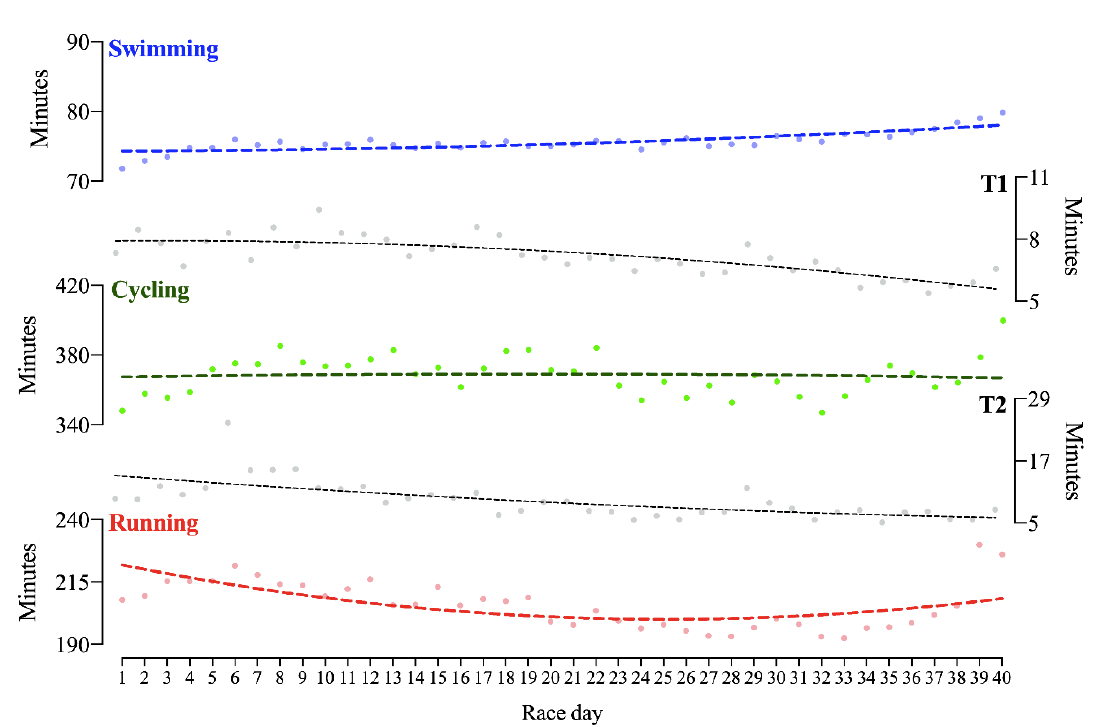
Figure 2. Times of swimming, cycling, running, and transition in 40 Ironman-distance triathlons in 40 days.